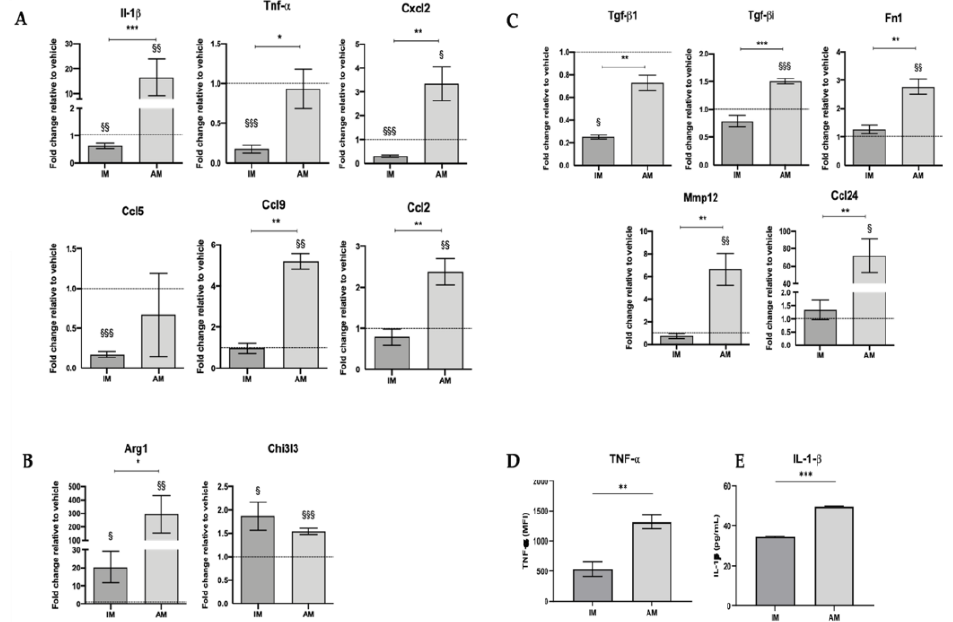
Figure 3. IM are activated towards an anti-inflammatory phenotype, and AM are in a transient activation state at day 7 after BLM-induced pulmonary fibrosis. Gene expression profile of interstitial and alveolar macrophages sorted from BLM and saline-injected lungs at day 7 of pro-inflammatory ( A ), anti-inflammatory ( B ), and pro-fibrotic factors ( C ). The fold change of gene relative expression of the respective group vehicle was set to 1. TNF- α protein expression was obtained by the mean fluorescence intensity (MFI) using the flow cytometry gating strategy in Figure 1B ( D), and expres- sion of IL- 1β was obtained by ELISA assay of IM-derived and AM-derived CM after 24 h culture ( E ). Data are represented as the mean ± SEM. * p < 0.05, ** p < 0.01, *** p < 0.001: treated IM vs. treated AM. § p < 0.05, §§ p < 0.01, §§§ p < 0.001: treated vs. vehicle. 3.3. Activated Interstitial Macrophages Promote Proliferation and Fibroblast Differentiation As the IM are the most representative lung macrophage population in the early phase of the mouse fibrosis model, next, their effects in fibrogenesis were investigated. Thus, IM were sorted from the lung at day 7 post BLM or post saline administration and subse- quently cultured to collect the CM. The lung fibroblast cell line was stimulated with sorted, IM-derived CM, and proliferation and differentiation were examined using MTS assay and Ki- 67 expression and expression of α -SMA and vimentin, respectively (Figure 4A). α -SMA is the most consistent marker for myofibroblast identification [24]. This cell type can also co- express α -SMA and vimentin; however, a single vimentin stain is reliable in distinguishing fibroblasts. Fibroblasts stimulated with untreated and treated, sorted, IM-derived CM exhibited increased viability and proliferation compared with the control, as shown by MTS assay (Figure 4B). However, no differences were found in MLg to Ki-67 expression by immuno- fluorescence (Figure 4C,D). After stimulation with sorted, IM-derived CM, single vimentin expression decreased and was mostly co- localized with α -SMA expression (Figure 4E,F) in both untreated and treated conditions. A significant increase in single α -SMA expression was observed when